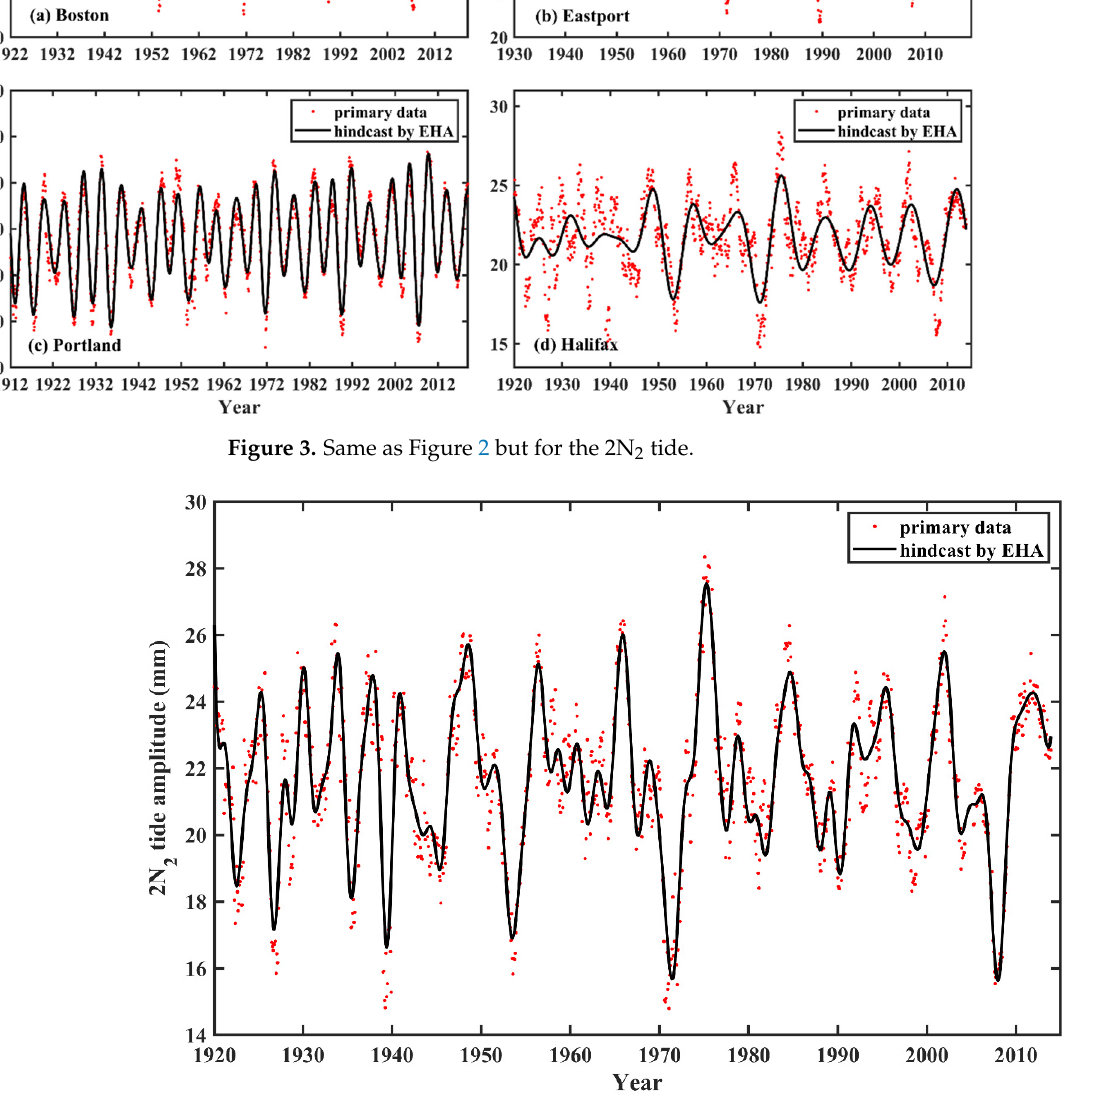
Figure 4. The primary amplitudes (red dots) and the hindcast amplitudes by the EHA method (black lines) of 2N 2 tide at Halifax by taking IP3 = 8 and IP4 = 35. lines) of 2N 2 tide at Halifax by taking IP3 = 8 and IP4 =